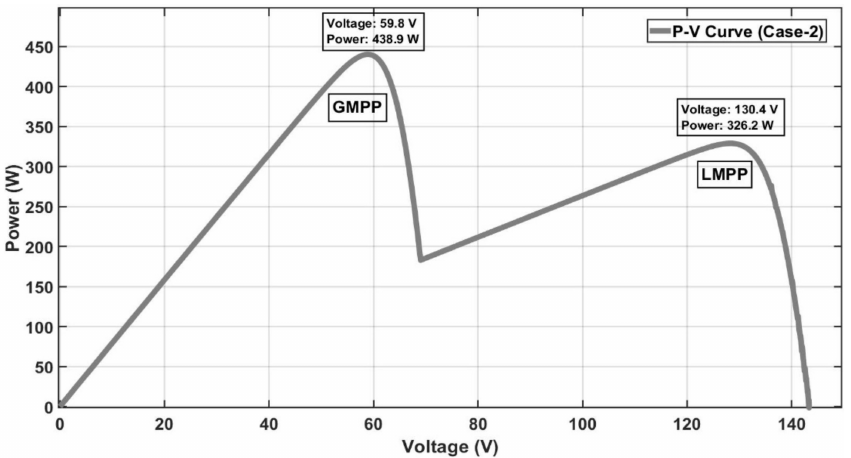
Figure 25. P-V curves